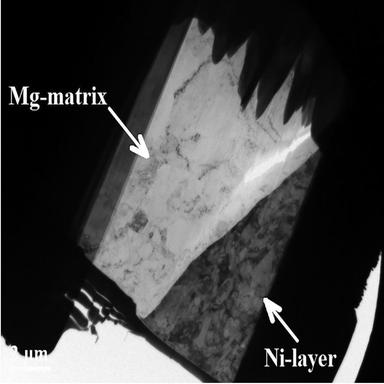
FIB sample preparation from the interface between nickel foil layers and magnesium matrix.